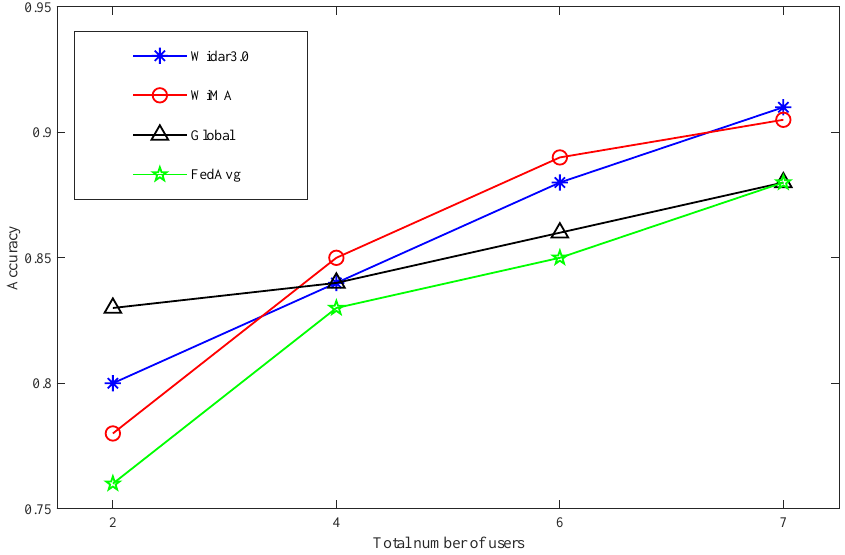
Figure 8. Comparison of WiMA algorithm with three